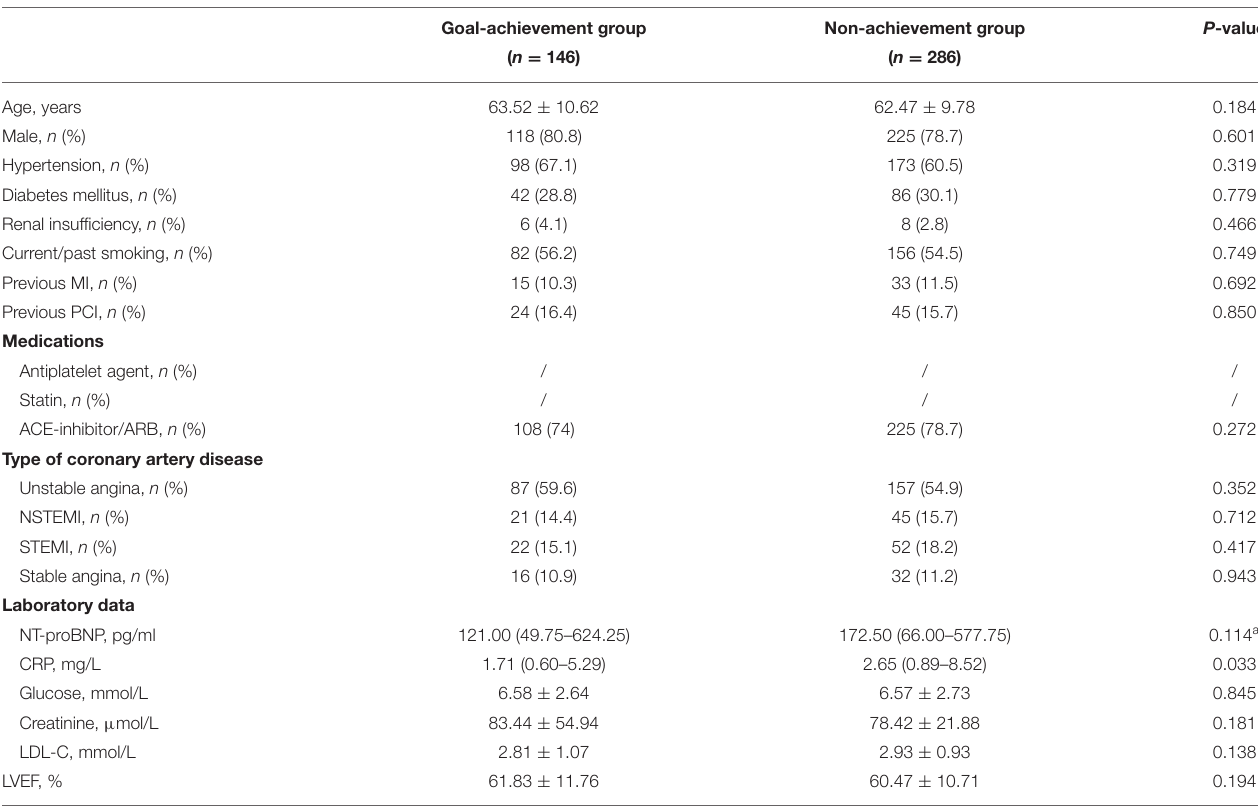
TABLE 1 | Baseline demographic